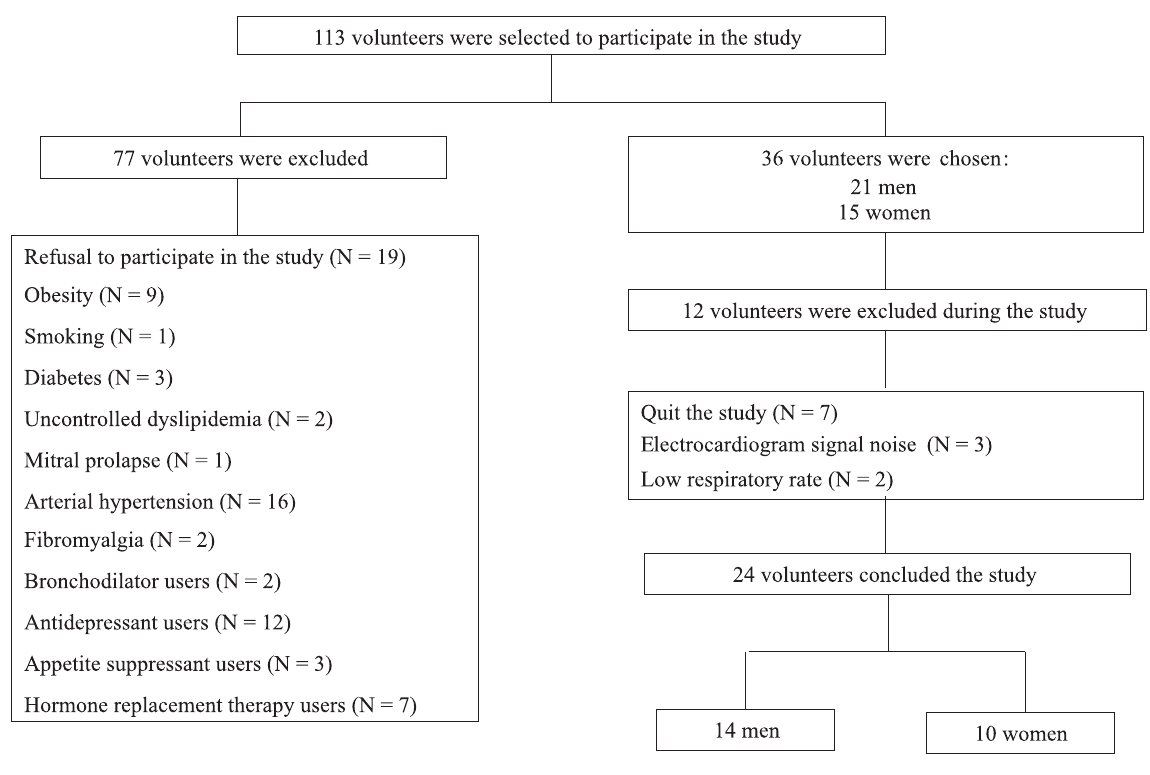
Figure 1. Flow diagram indicating sampling loss in the